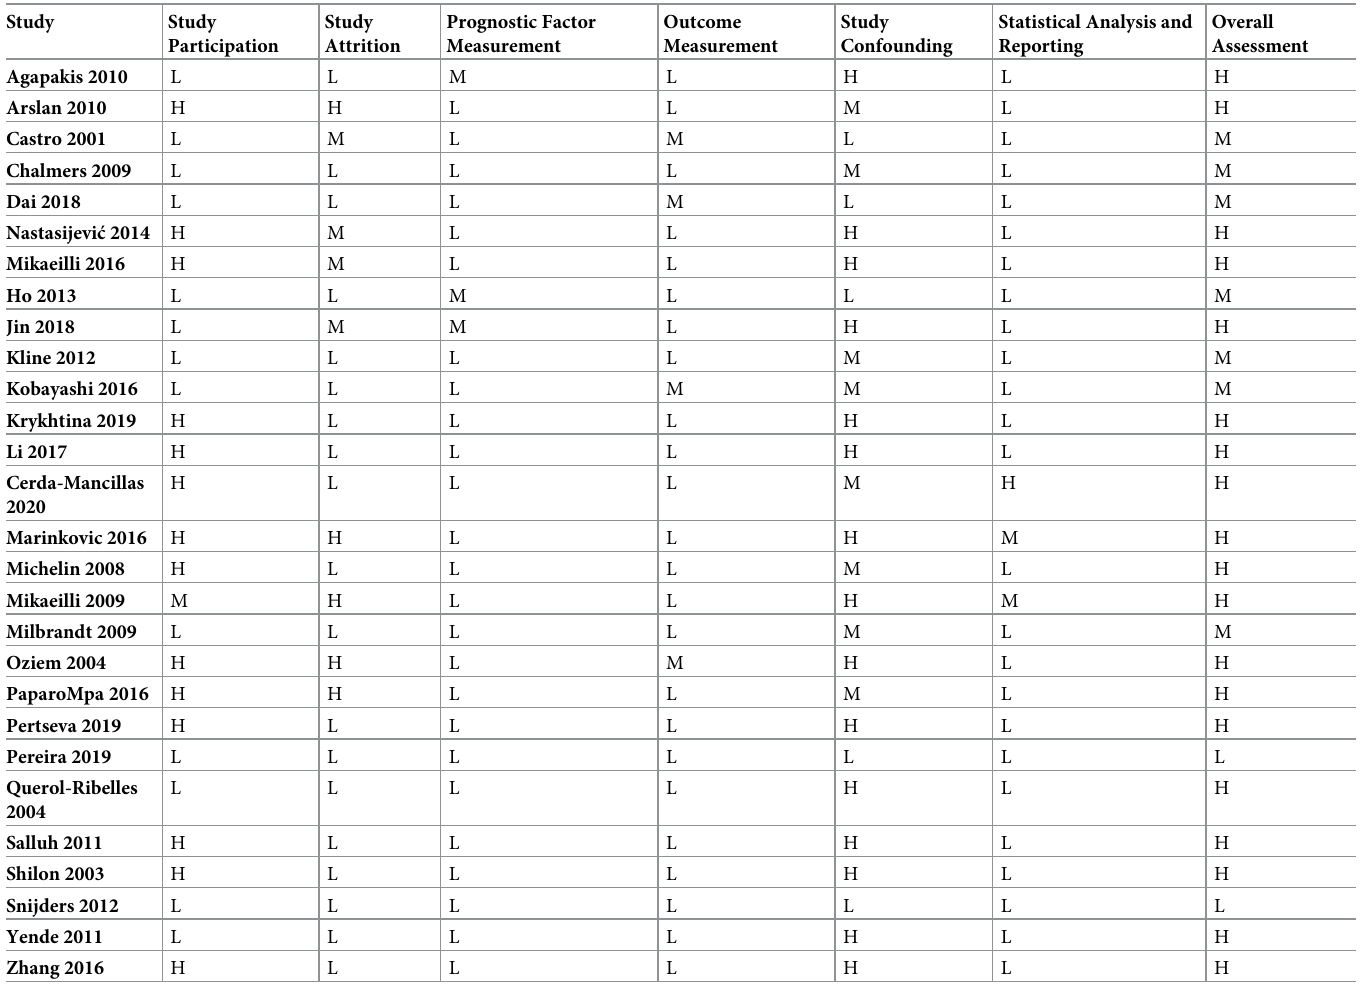
Table 2. Quality assessment of individual studies using the QUIPS